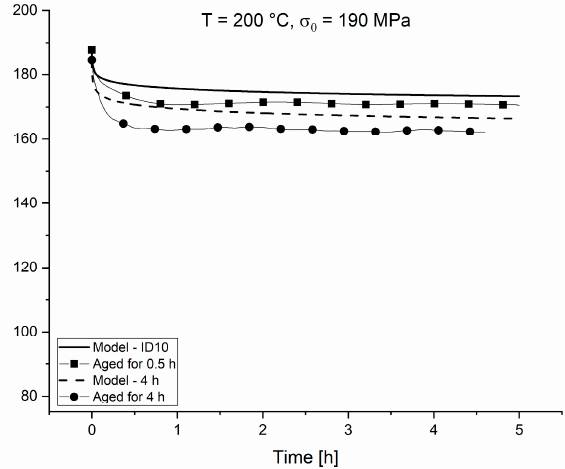
Figure 12. Comparison of experimental and simulated stress relaxation curves tested in aged condition at 200 °C with test stress of 190 MPa.